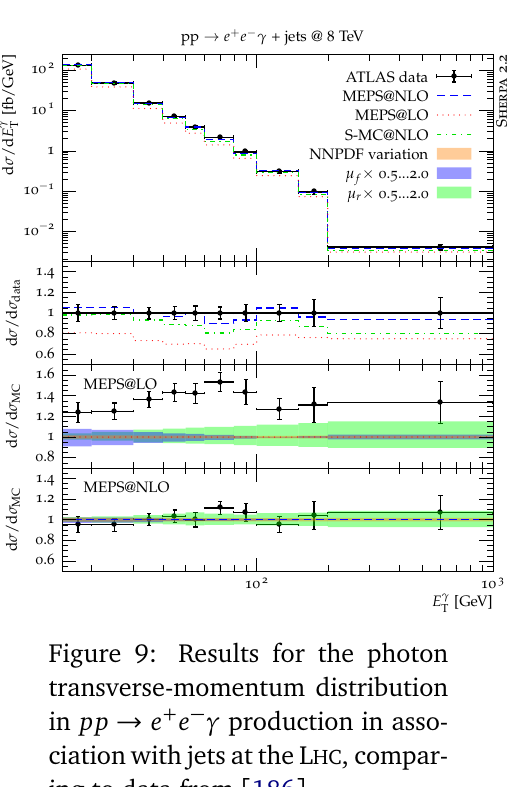
Figure 9: Results for the photon transverse-momentum distribution in pp → e + e − γ production in asso- ciation with jets at the L HC , compar- ing to data from [ 186 ] .